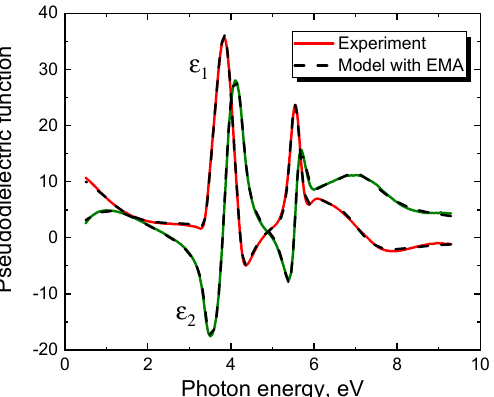
Figure 2. Dependence of the pseudodielectric function ( ε 1 is its real part, ε 2 is its imaginary part) of a silicon carbide (SiC)/Si(100) sample on the photon energy, measured in the range of 0.5–9.3 eV by an ultraviolet ellipsometer J.A. Woollam VUV-WASE with a rotating analyzer (solid line). The dashed line is the same relationship calculated using the Effective Media Approximation (EMA) model.